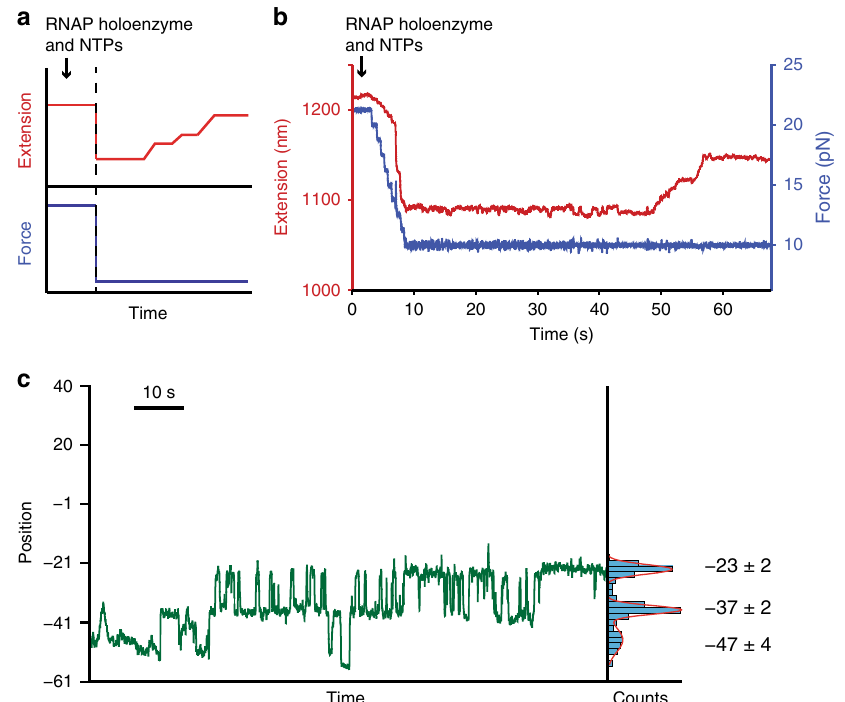
Fig. 3 Real-time observations of dsDNA-stabilizing contacts remodeled during transcription initiation. a Force protocol for real-time initiation experiments (blue), displayed with a notional data showing RNAP binding and initiation (red). A DNA hairpin is held initially at constant high force, suf fi cient to keep it unfolded, resulting in a large starting tether extension. RNAP holoenzyme plus NTPs are introduced into the fl ow chamber (black arrow) while high force is maintained. After the fl ow stabilizes, the force is lowered below the hairpin opening force ( F 1/2 , vertical dashed line), and thereafter maintained at ~ 1 – 2 pN below F 1/2 . The hairpin refolds promptly, after which the holoenzyme binds and tether extension increases as RNAP remodels contacts during subsequent transcription. b A representative experimental record, showing the external load (blue) and concomitant tether extension (red) for the 40DT template sequence. The initial force, ~ 20 pN, was decreased in a series of steps to ~ 9 pN. After 48 s, transcription led to an increase in tether extension of ~ 50 nm. c RNAP holoenzyme position under ~ 11 pN load in the absence of NTPs; the enzyme was introduced shortly after the start of the record. Measured extension (in nm) were converted to nucleotide position relative to the TSS (+1 site) of the